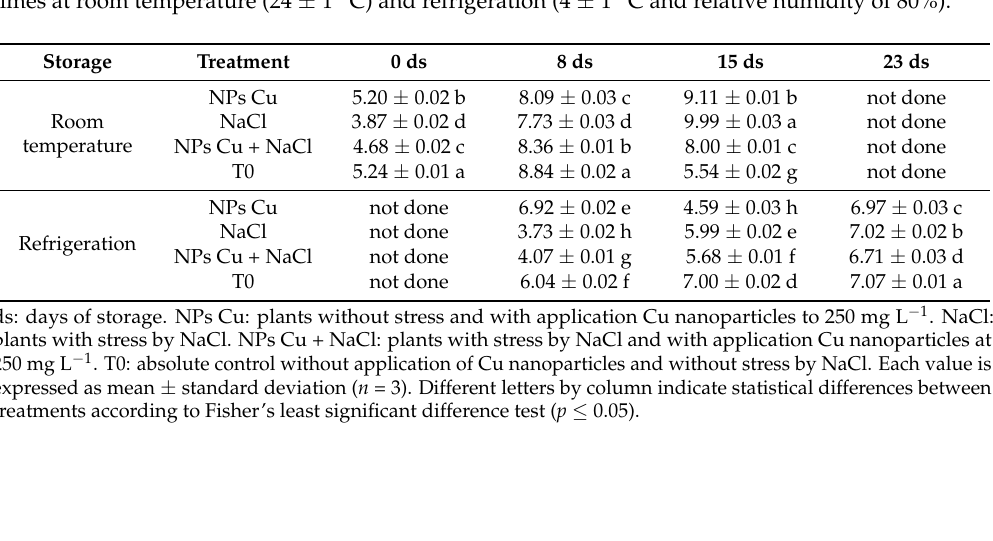
Table 3. Lycopene content (milligrams per 100 g fresh weight) in tomato fruits at different storage times at room temperature (24 ± 1 ◦ C) and refrigeration (4 ± 1 ◦ C and relative humidity of